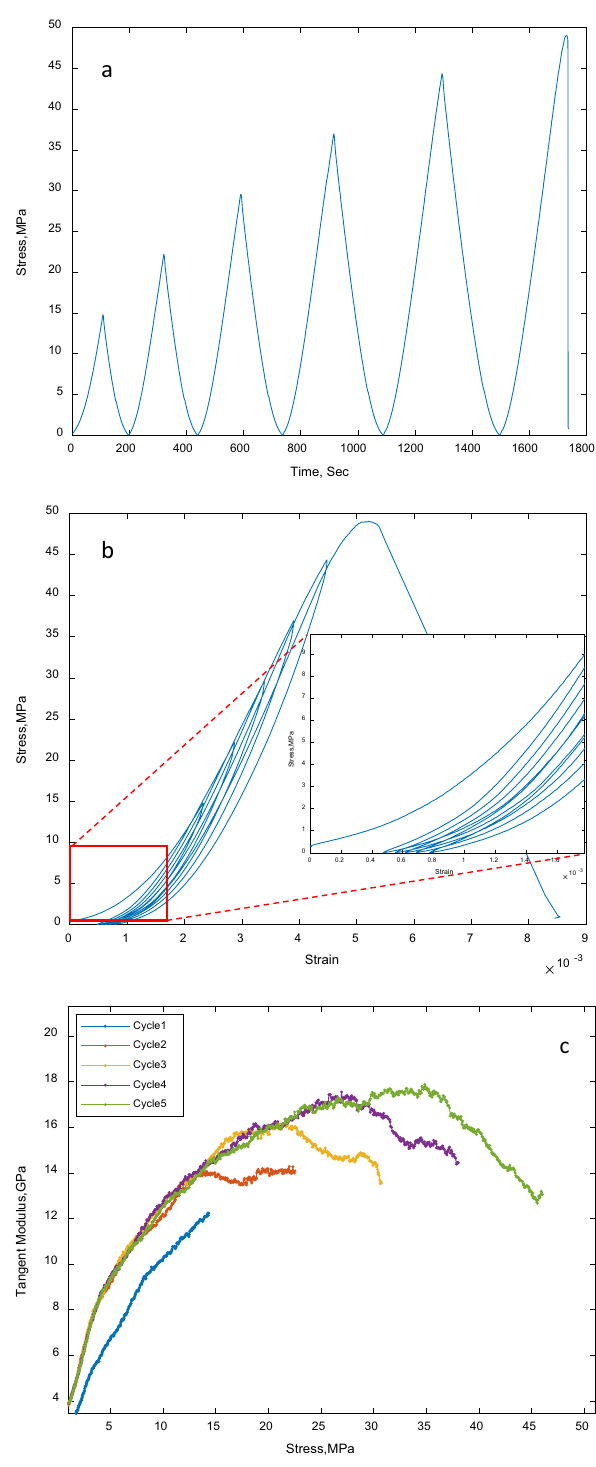
Fig. 14 Cyclic loading unloading of Gasford sandstone showing a Loading cycles; b Hysteresis loop; c Tangent modulus